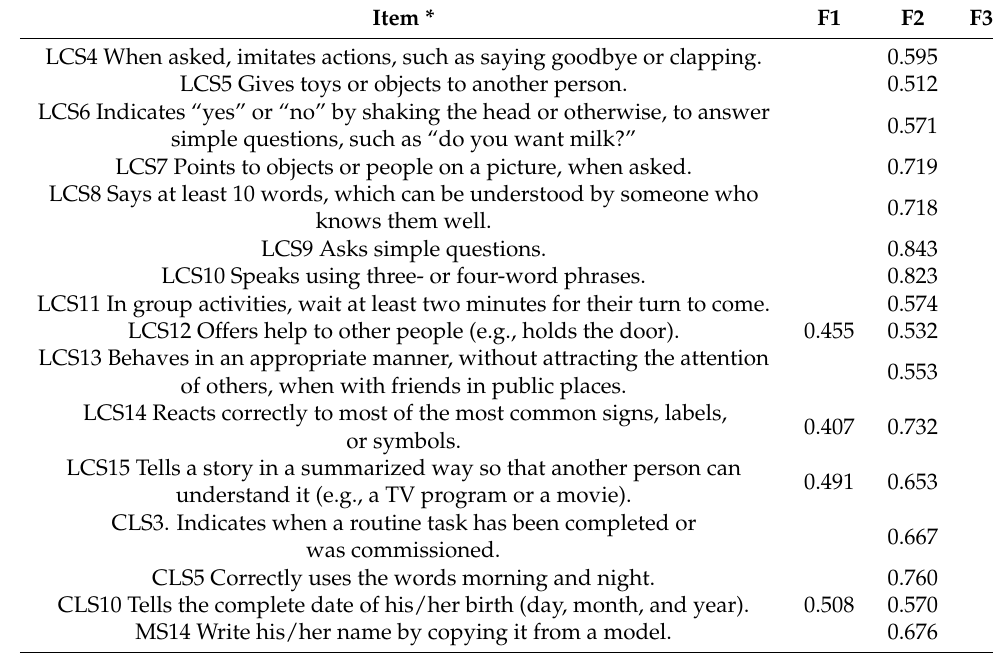
Table 2. Linguistic and communication skills dimension: items and factor load. Item * F1 F2 F3 LCS4 When asked, imitates actions, such as saying goodbye or clapping.